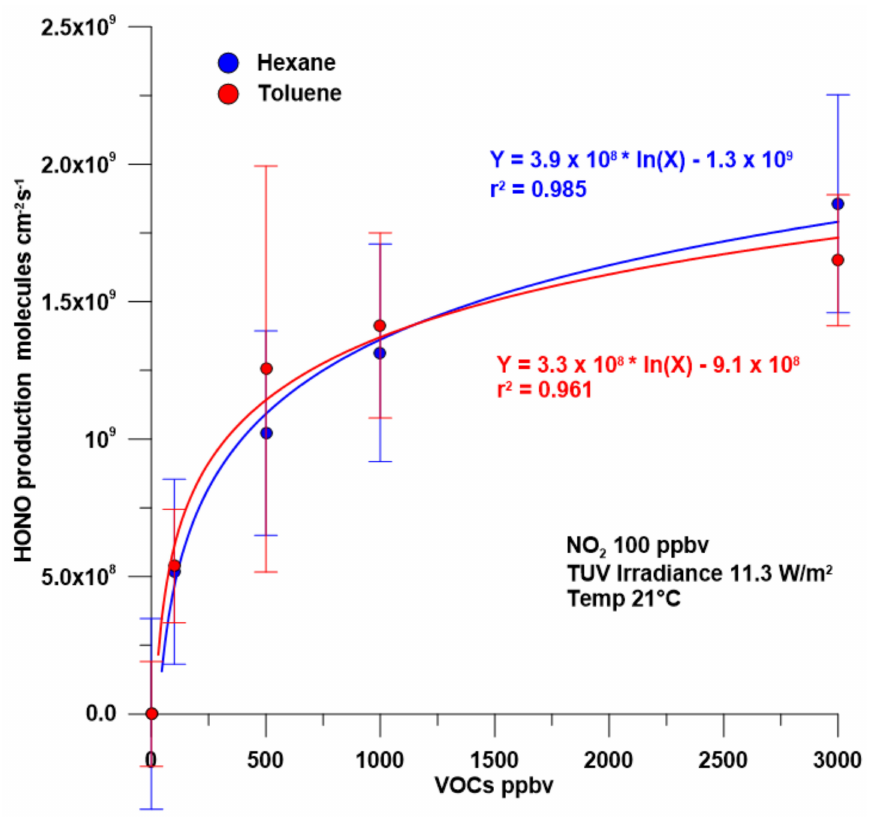
Figure 4. HONO production rates as a function of toluene and hexane mixing ratios. NO 2 and TUV were fixed as 100 ppbv and 11.3 Wm − 2 ,